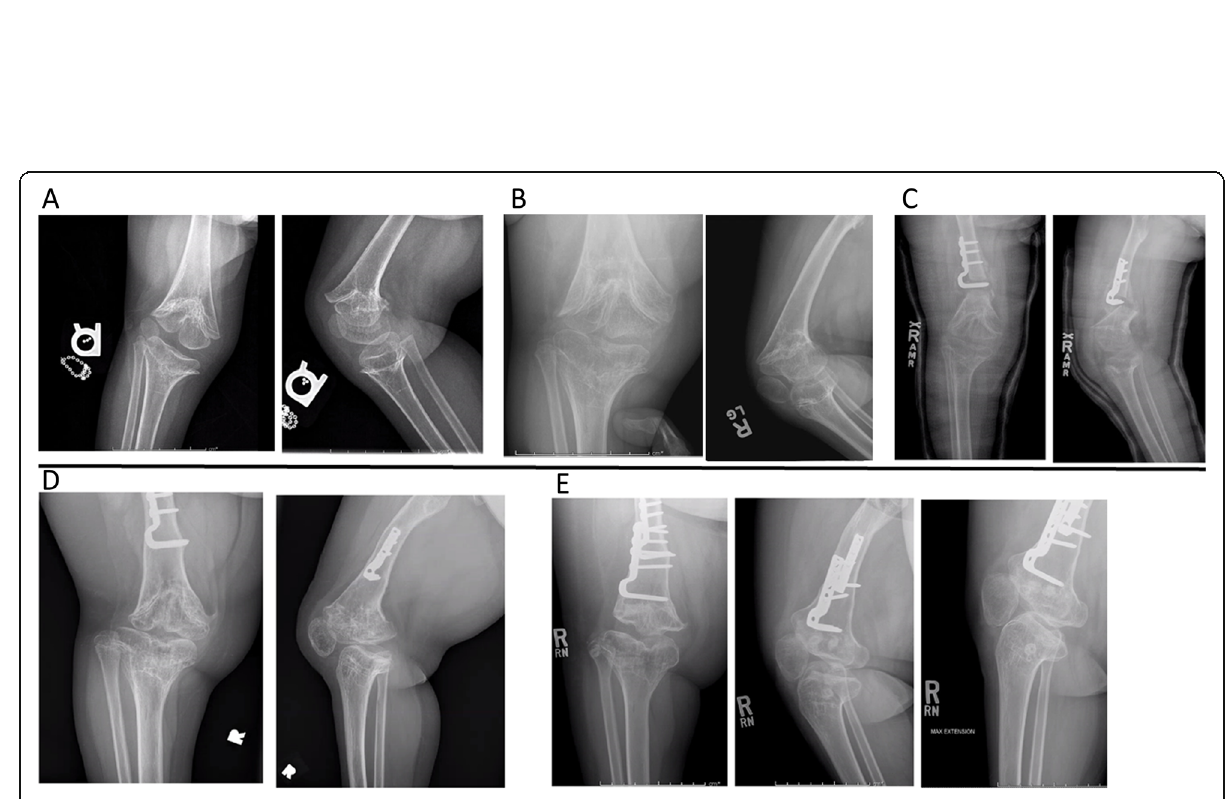
Fig. 1 a The first row includes images from the skeletal survey performed at age 7 months, which show brachycephaly, mild midface hypoplasia, right distal femoral and proximal tibial coned epiphyses, brachydactyly, and advanced bone age with ossification of the carpal and tarsal bones. b : The second row includes images obtained at age 33 months, demonstrating the significant progression of midface hypoplasia, brachycephaly, and cone shaped epiphysis in the right knee, brachydactyly, and advanced bone age